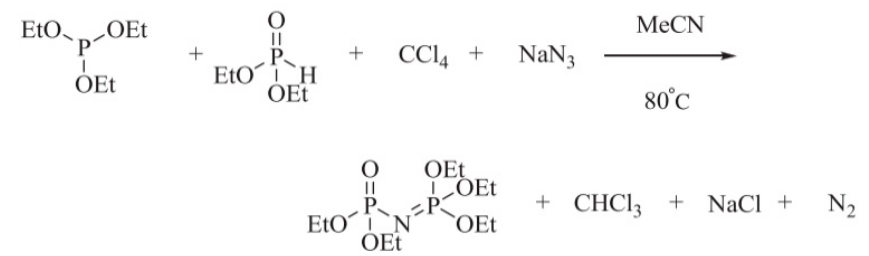
Figure 14. The synthetic route of triethoxyphosphazen-N-phosphoryldiethylester (PNP). Adopted from Ref. [217].